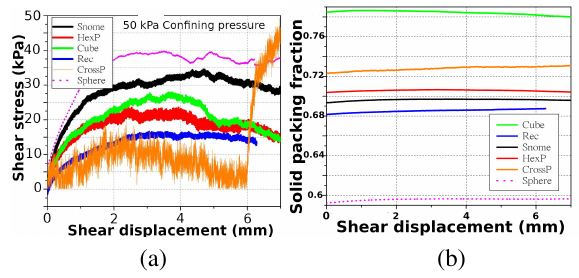
Figure 6. (a) Stress-displacement curve and (b) solid fraction vs strain for all shapes at 50